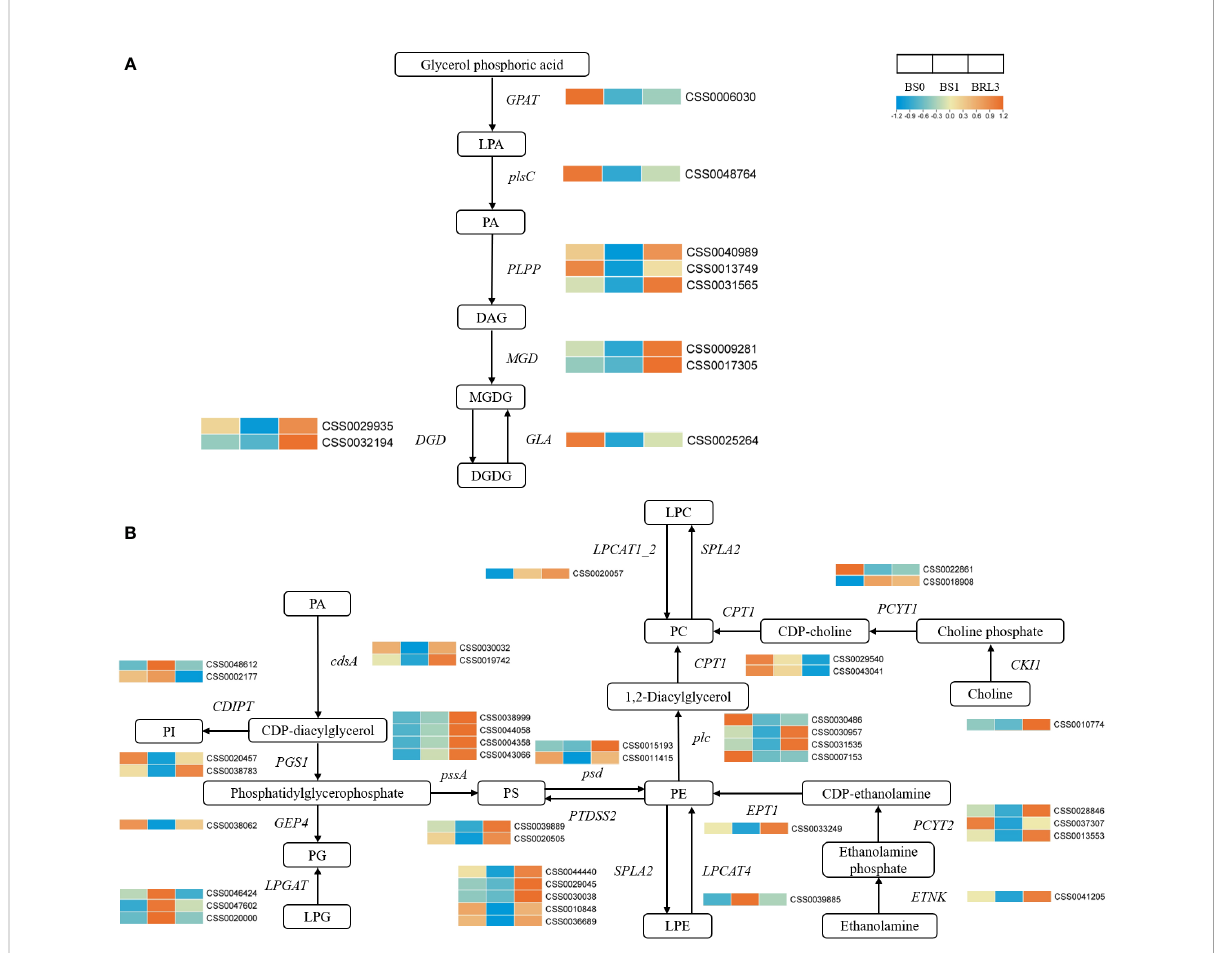
FIGURE 7 Effects of shading and light restoration on the expression of key genes in the pathway of Glycerolipid metabolism and Glycerophospholipid metabolism in BJG. (A) The expression of key genes in the pathway of glycerolipid metabolism. GPAT , glycerol-3-phosphate O-acyltransferase; plsC , 1-acyl-sn-glycerol-3-phosphate acyltransferase; PLPP , phosphatidate phosphatase; MGD , 1, 2-diacylglycerol 3-beta-galactosyltransferase; DGD , DGDG synthase; GLA , alpha-galactosidase. (B) The expression of key genes in the pathway of glycerophospholipid metabolism. cdsA , phosphatidate cytidylyltransferase; PGS1 , CDP-diacylglycerol-glycerol-3-phosphate 3-phosphatidyltransferase; GEP4 , phosphatidylglycerophosphatase; LPGAT , lysophosphatidylcholine acyltransferase; pssA , CDP-diacylglycerol-serine O-phosphatidyltransferase; psd , phosphatidylserine decarboxylase; PTDSS2 , phosphatidylserine synthase 2; SPLA2 , secretory phospholipase A2; LPCAT4 , lysophospholipid acyltransferase; plc , phospholipase C; LPCAT1_2 , lysophosphatidylcholine acyltransferase/lyso-PAF acetyltransferase; CPT1 , diacylglycerol cholinephosphotransferase; PCYT1 , choline-phosphate cytidylyltransferase; CKI1 , choline kinase; ETNK , thanolamine kinase; PCYT2 , ethanolamine-phosphate cytidylyltransferase; EPT1 , ethanolaminephosphotransferase; CDIPT , CDP-diacylglycerol-inositol 3- phosphatidyltransferase. Orange color indicates high, and blue color indicates